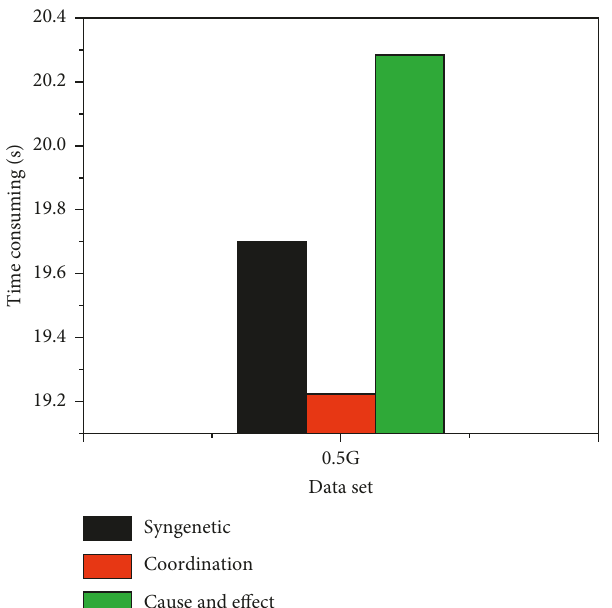
Figure 5: Time consumption of different patterns with 0.5G dataset.